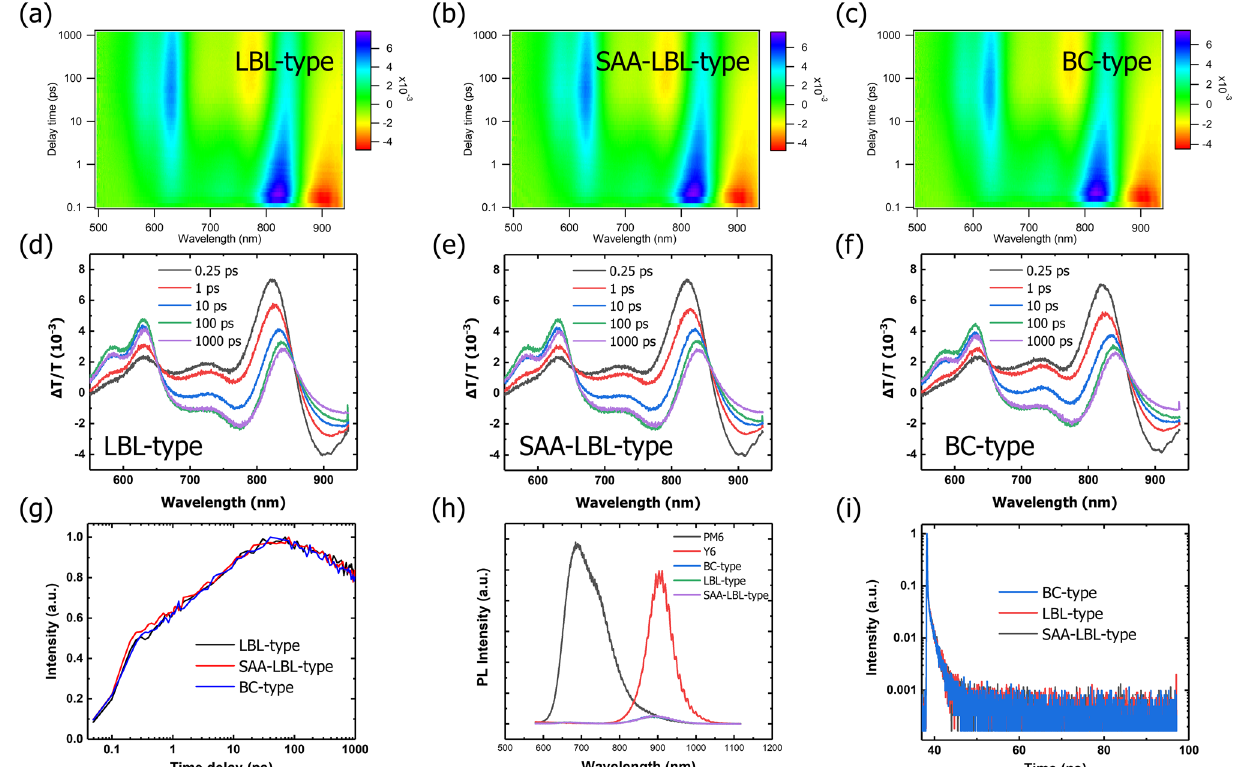
Fig. 7 Color plots of the TA spectra for a LBL-type, b SAA-LBL-type and c BC-type blend films in the range of 500–930 nm. TA spectra of d LBL-type, e SAA-LBL-type and f BC-type blend films in the range of 500–960 nm of the blend films at different delay times. j TA traces of three blend films probed at 630 nm. h PL spectra of pristine PM6 and Y6 films, BC-type, LBL-type, and SAA-LBL-type blend films. i TRPL spectra of BC-type, LBL-type and SAA-LBL-type blend